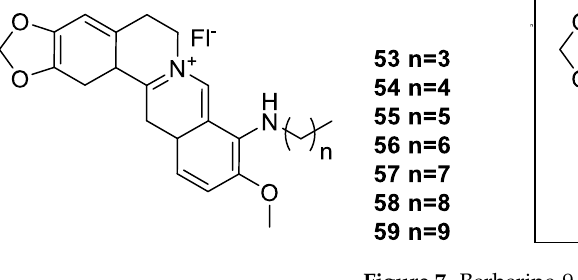
Figure 7. Berberine-9- N derivatives.